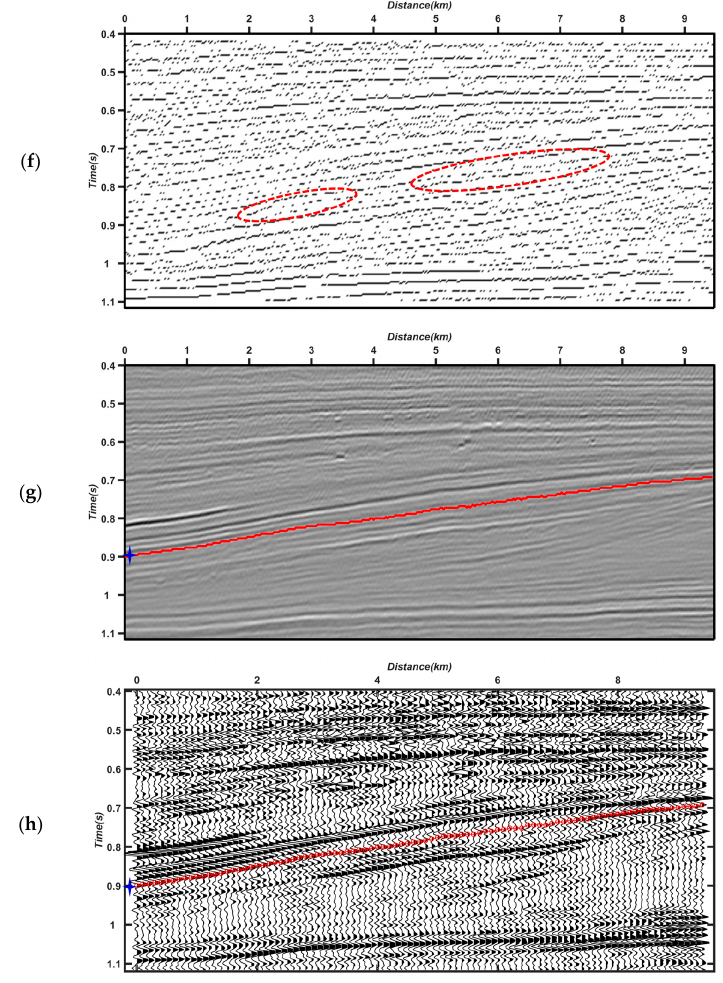
Figure 6. The result for an extracted inline slice of F3 seismic data. ( a ) Seismic data, ( b ) troughs of seismic data, ( c ) peaks of seismic data, ( d ) instantaneous phase attribute, ( e ) troughs of instantaneous phase, ( f ) peaks of instantaneous phase, and tracked horizon (red curve) overlaid with ( g ) image and ( h ) waveform of seismic data.